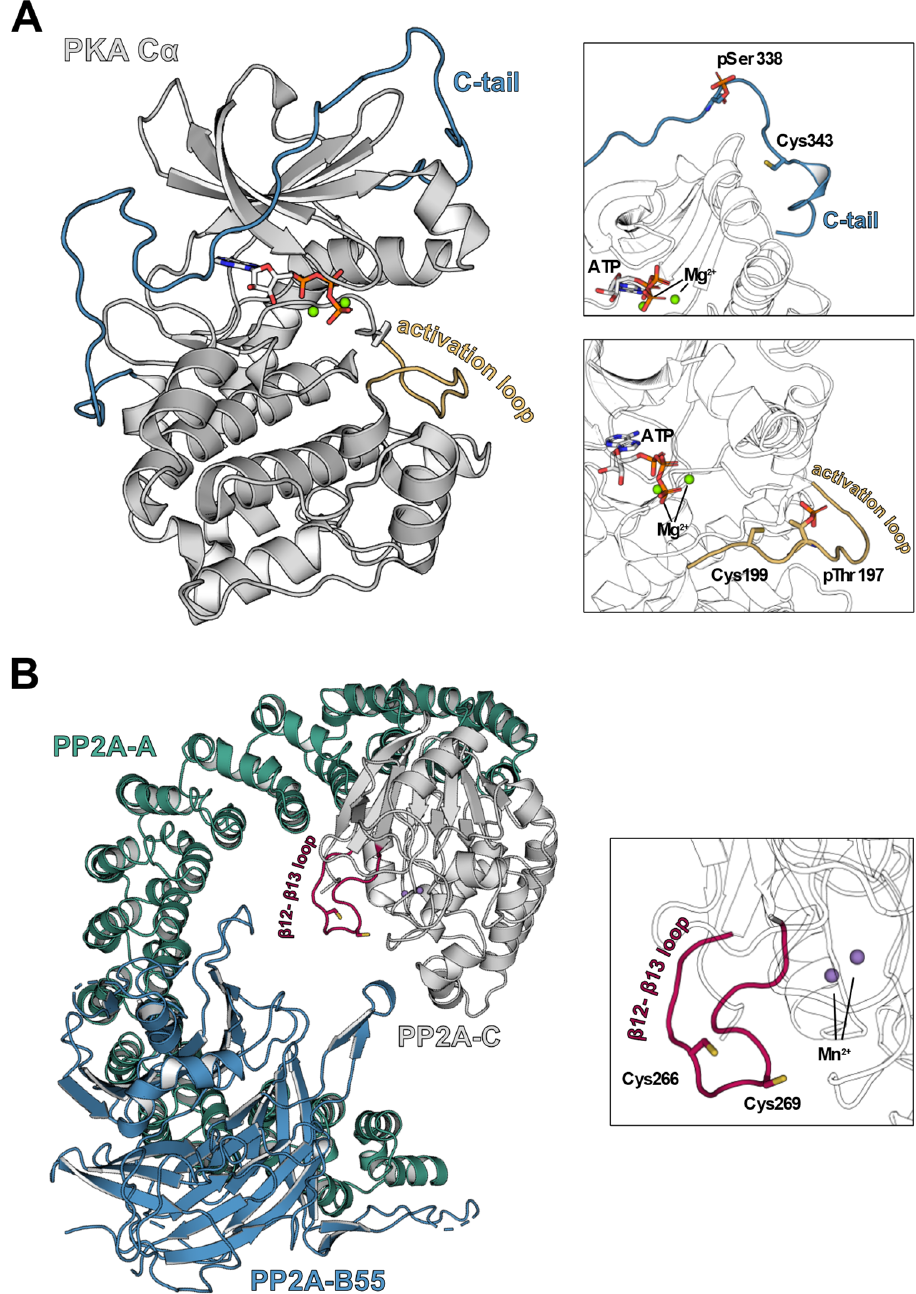
Figure 3. Structures of PKA-C α and PP2A in ribbon representation. ( A ) cAMP-dependent protein kinase catalytic subunit Table 2. ions [60] (PDB 4WB5). The catalytic subunit of PKA consists of two lobes, the N-lobe consists mainly of β -sheets and the C-lobe comprises α -helical structures. In the latter, a redox-sensitive cysteine, Cys199, is located in the activation loop (yellow) close to the catalytic cleft, which was shown to inhibit kinase activity upon oxidation. Another cysteine susceptible to redox processes, Cys343, is found in the C-terminal tail (C-tail, blue) that spans from the C-lobe to the N-lobe of PKA-C α . ( B ) Hetero trimeric holoenzyme of protein phosphatase 2A (PP2A) [61] (PDB 3DW8). The fully active PP2A holoenzyme consists of the core enzyme comprising regulatory subunit, here PP2A-B55 (blue). Localized on the β 12- β 13 loop of PP2A-C (magenta), duced inhibition of PP2A-C via disulfide bridge formation.